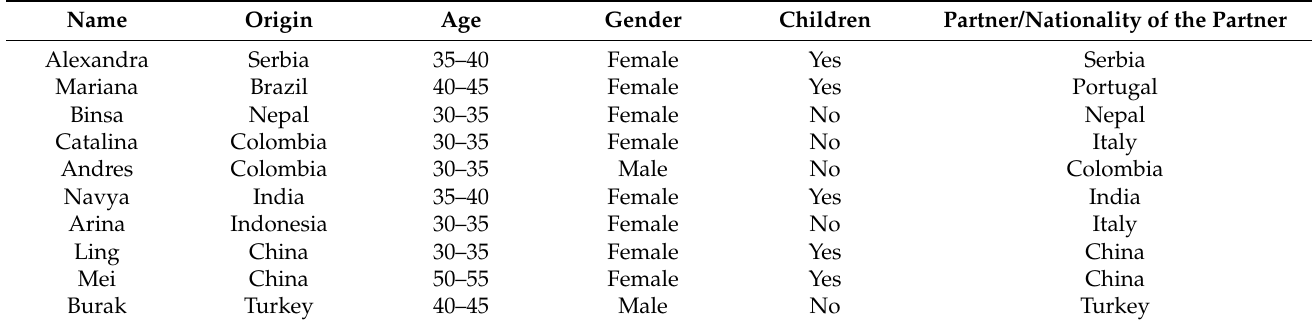
Table 1. Profiles of the interviewees: HSMs who moved due to their partner’s trajectory.